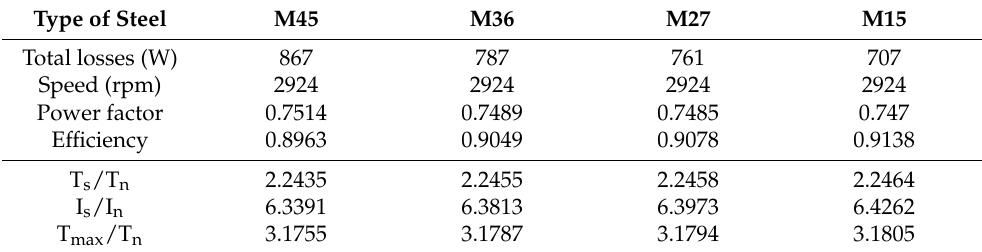
Table 10. Nominal, start, and maximum torque results on the 7.5 kW motor (equal output power criteria, variations of type of